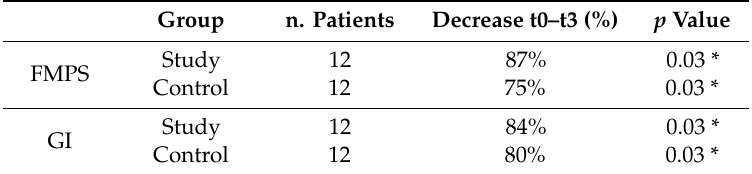
Table 1. Full mouth plaque score (FMPS) and Gingival index (GI) reduction from t0 to t3 in study and control groups.